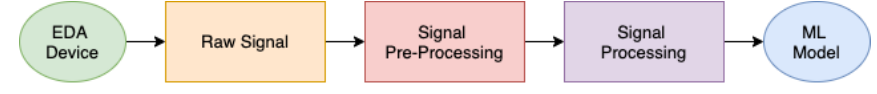
Figure 3. Usual stages in signal acquisition, pre-processing and